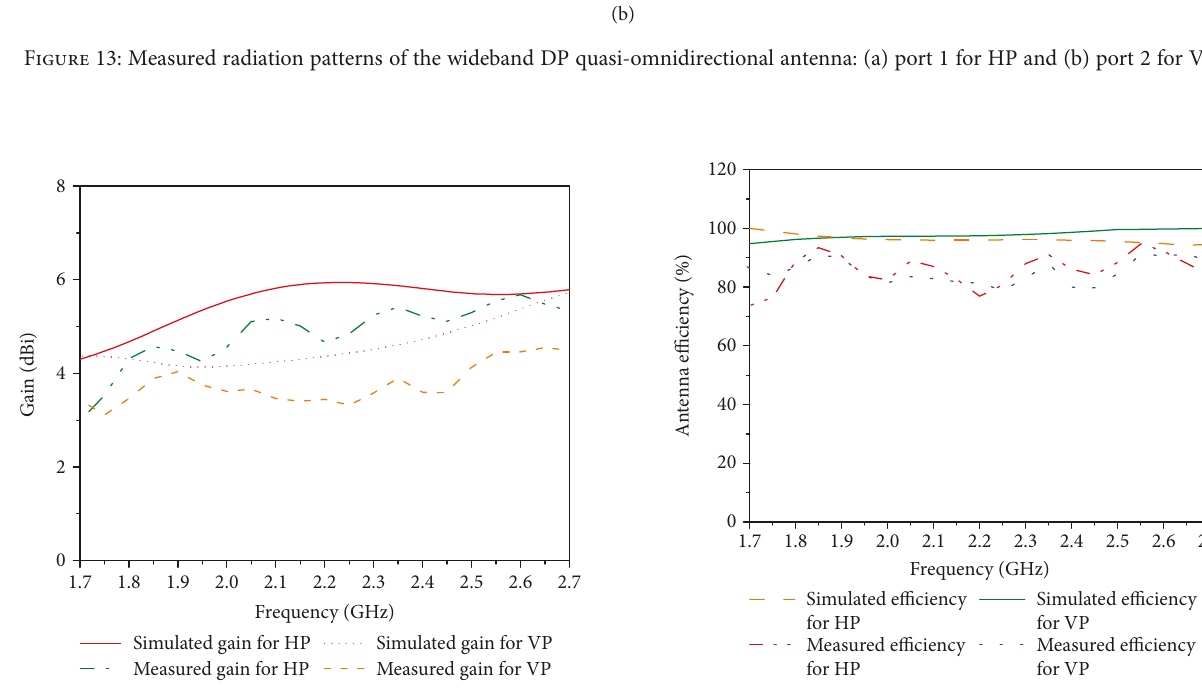
Figure 15: E ffi ciency of the wideband DP quasi-omnidirectional